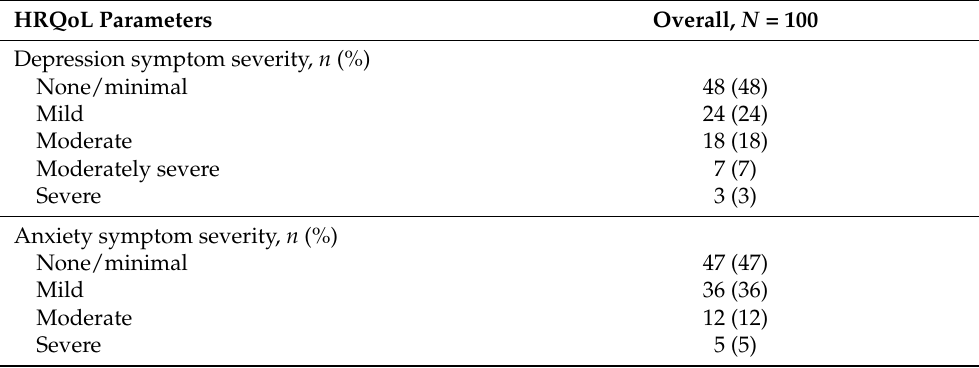
Table 2. Health-related quality of life outcomes.